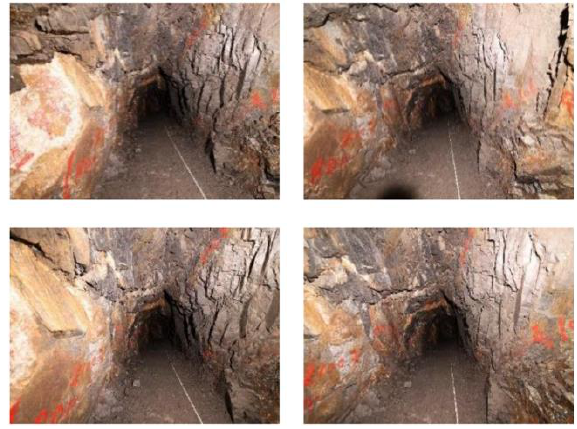
Figure 6. Example image of tunnel double-line parallel photography